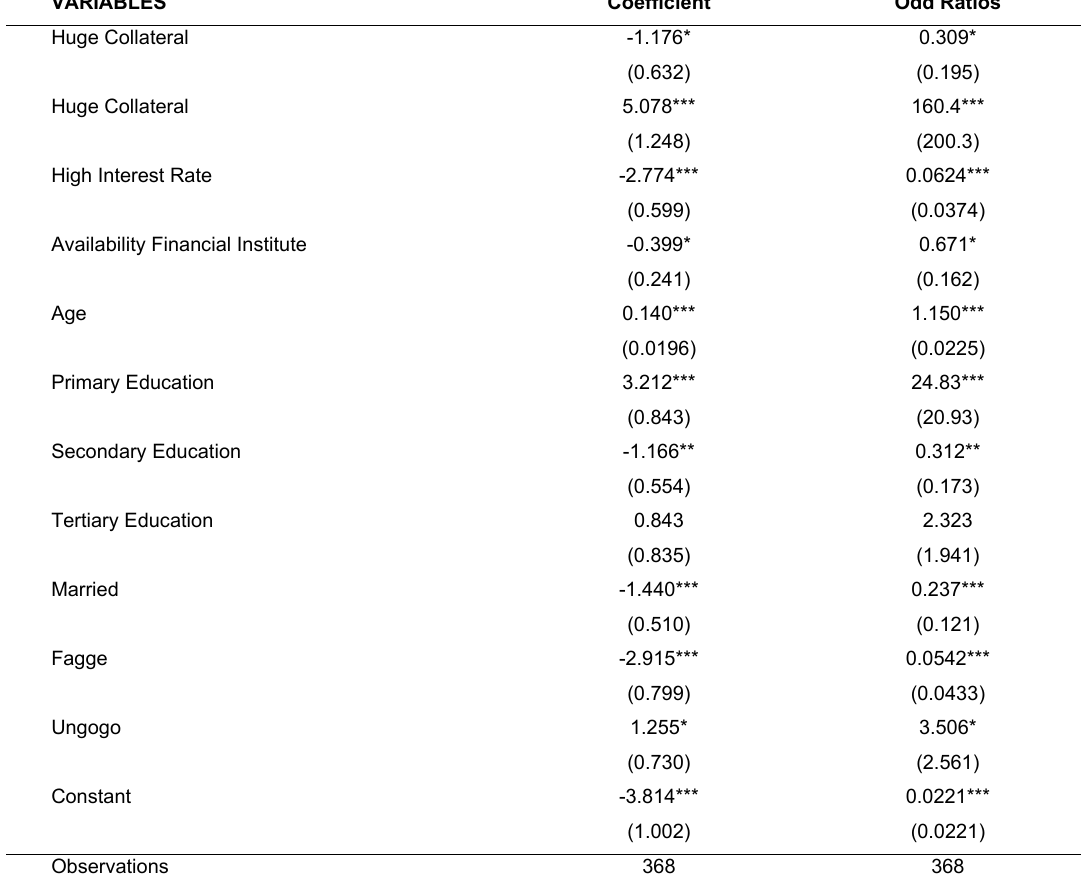
Table 2. Collateral and interest constraints to women entrepreneurs’ access to credit